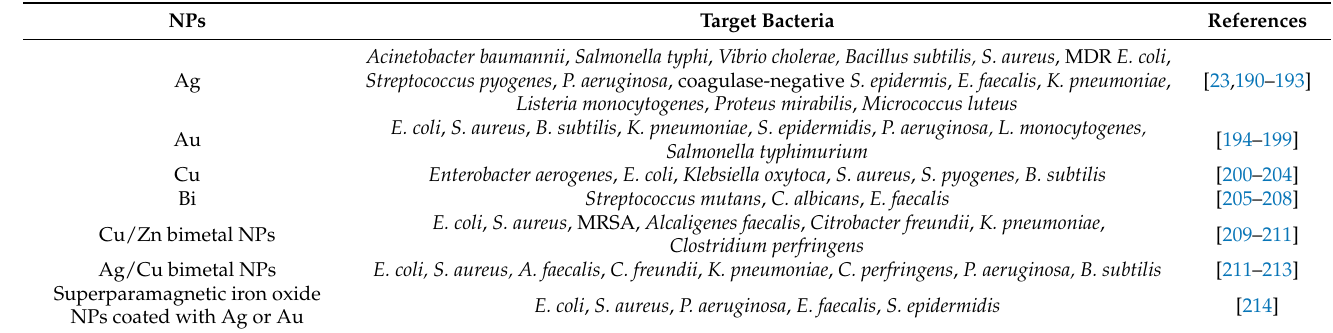
Table 3. Antibacterial activity of metal nanoparticles against different bacteria. Target